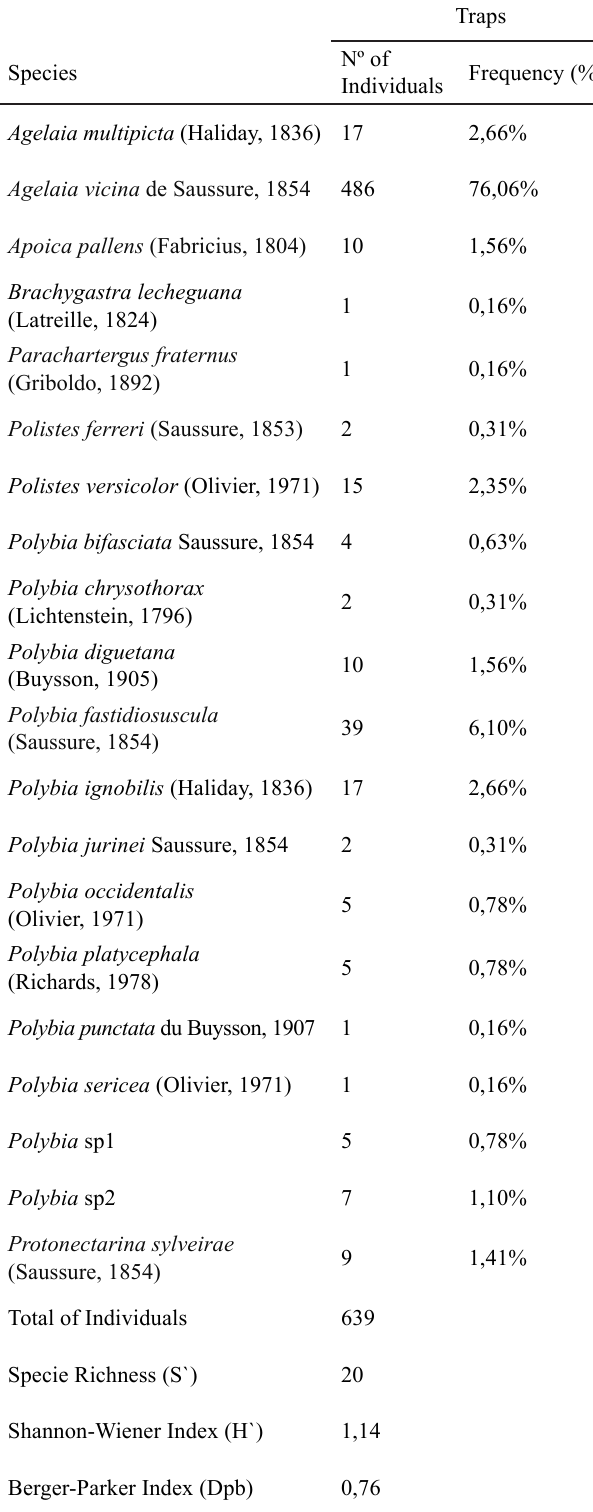
Table 1 . Total richness, diversity and dominance of species of